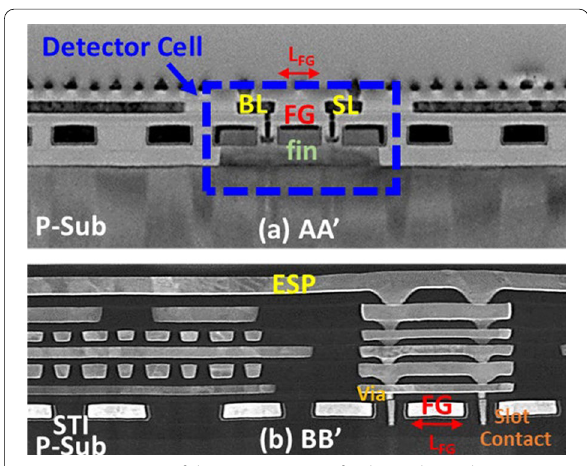
Fig. 3 TEM image of the cross section of a the n‑channel FG FinFET transistor and b the ESP with a slot‑contact coupling structure, where the FG length, L FG 0.14 μm =